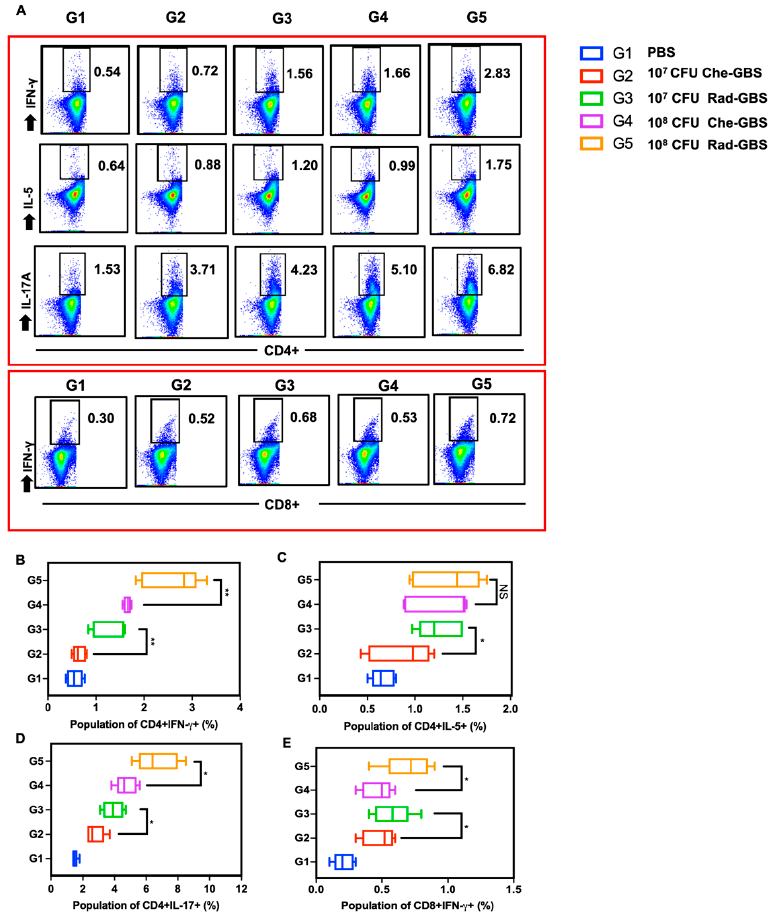
Figure 4. Cellular immunogenicity is potently elicited via immunization with Rad-GBS. Mice were intramuscularly immunized with various dosages of Rad-GBS or Che-GBS as shown above, and mice injected with PBS were used as the control group. Seven days after the last vaccination, the spleen cells were isolated, and cell suspensions were re-stimulated with 20 µg/mL GBS whole-cell lysate for 12 h and subsequently used for the flow cytometry analysis. ( A ) The functional populations of T cells were classified according to the expression of CD4 + and CD8 + of interferon gamma (IFN- γ ), interleukin-5 (IL-5), or interleukin-17A(IL-17A) assessed in all mouse groups. Antigen-specific cytokine-producing population in isolated spleen cells. For mouse groups, measurements were made for the population of ( B ) CD4+IFN- γ + , ( C ) CD4 + IL5 + , ( D ) CD4 + IL-17A + , and ( E ) CD8 + IFN- γ + . All data are expressed as the mean ± standard deviation of five splenocyte samples and three independent experiments. ** stands for p < 0.01, * stands for p < 0.05, and NS for not significant.